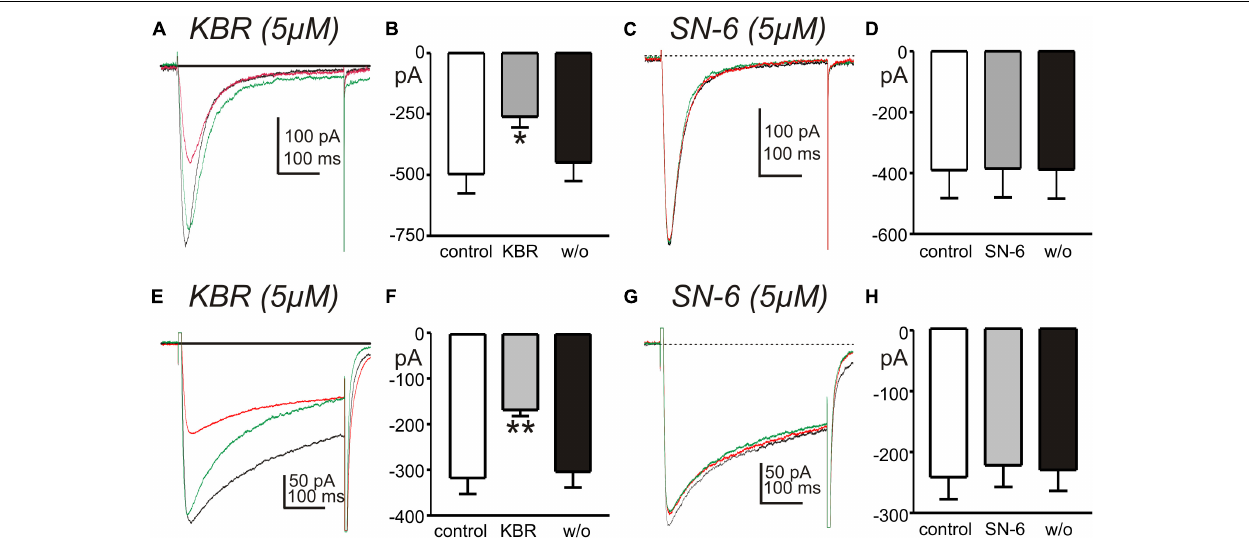
FIGURE 8 | Effects of NCX antagonists on T- and L-type Ca 2 + currents. (A,C) Show current responses to step depolarizations of HEK 394 cells (–80 to –40 mV) expressing Ca V 3.2 channels before (black traces), in the presence of KB-R7943 (5 µ M, KBR) or SN-6 (5 µ M) (red traces), and after wash out of the drugs (green traces). (B,D) Summaries of the effects of KB-R7943 and SN-6 on peak T-type Ca 2 + currents in 5 and 4 cells, respectively (* p < 0.05). (E,G) Show L-type Ca 2 + currents evoked by step depolarizations of colonic SMC (–80 to 0 mV) before (black traces), in the presence of KB-R7943 (5 µ M, KBR) or SN-6 (5 µ M) (red traces), and after wash out of the drugs (green traces). (F,H) Summaries of the effects of KB-R7943 and SN-6 on peak L-type Ca 2 + currents ( n = 5 cells for each experiment; ** p <